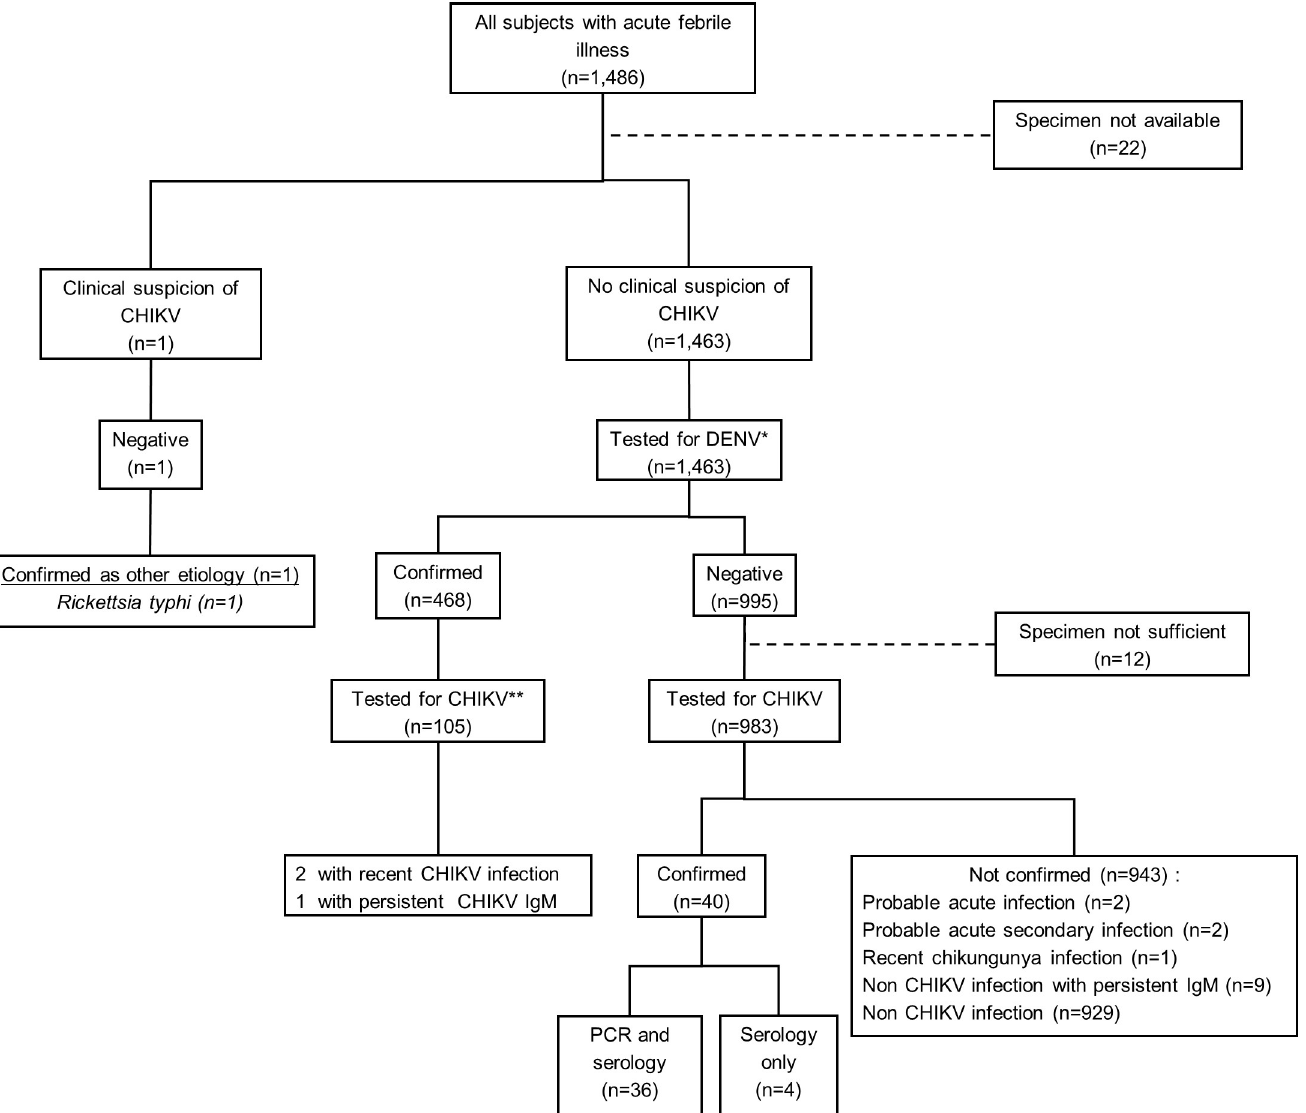
Fig 1. Study algorithm to identify acute chikungunya infection. � DENV IgM/IgG, NS1, RT-PCR; �� CHIKV IgM/IgG, RT-PCR.